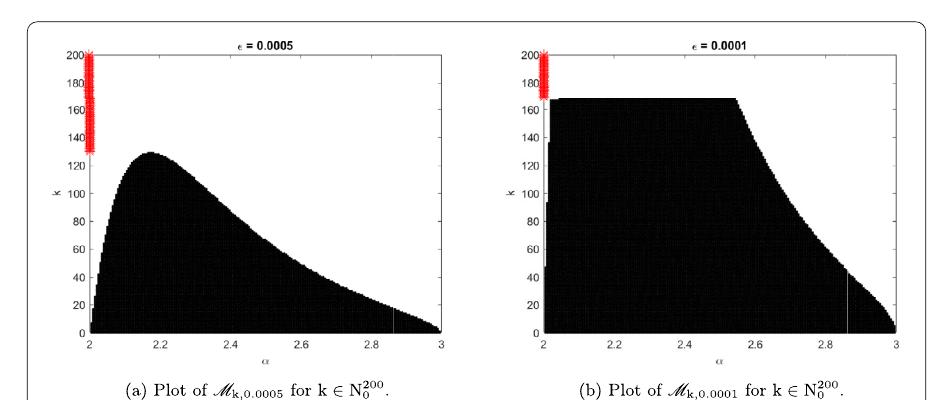
Figure 3 Plot of M k , (cid:4) for k ∈ N 200 0 and different values of (cid:4)